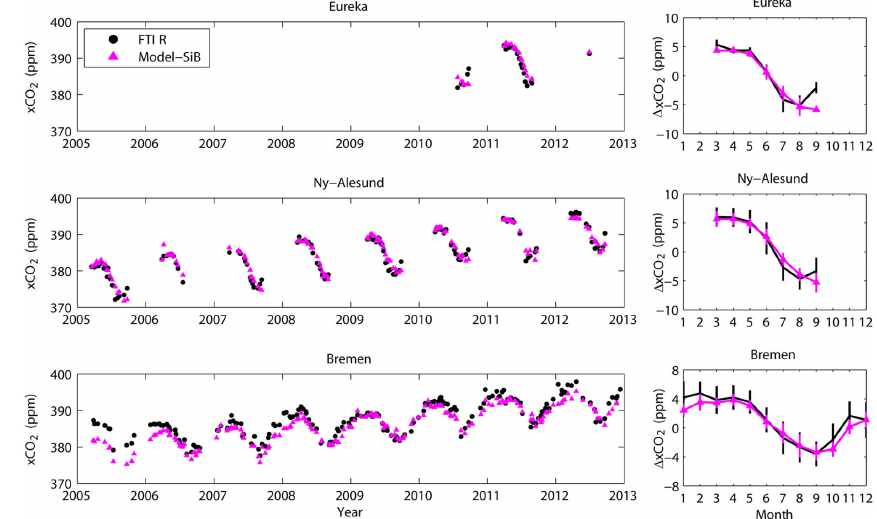
Figure 6. Comparison of FTIR measurements of CO 2 (black dots) to model simulations with SiB land fluxes (magenta triangles) at Eureka, Ny-Ålesund, and Bremen. The left panels show weekly means from 2005 to 2012. The right panels show the monthly mean relative xCO 2 (relative to annual mean) averaged for multiple years. The error bars are the standard deviations of each